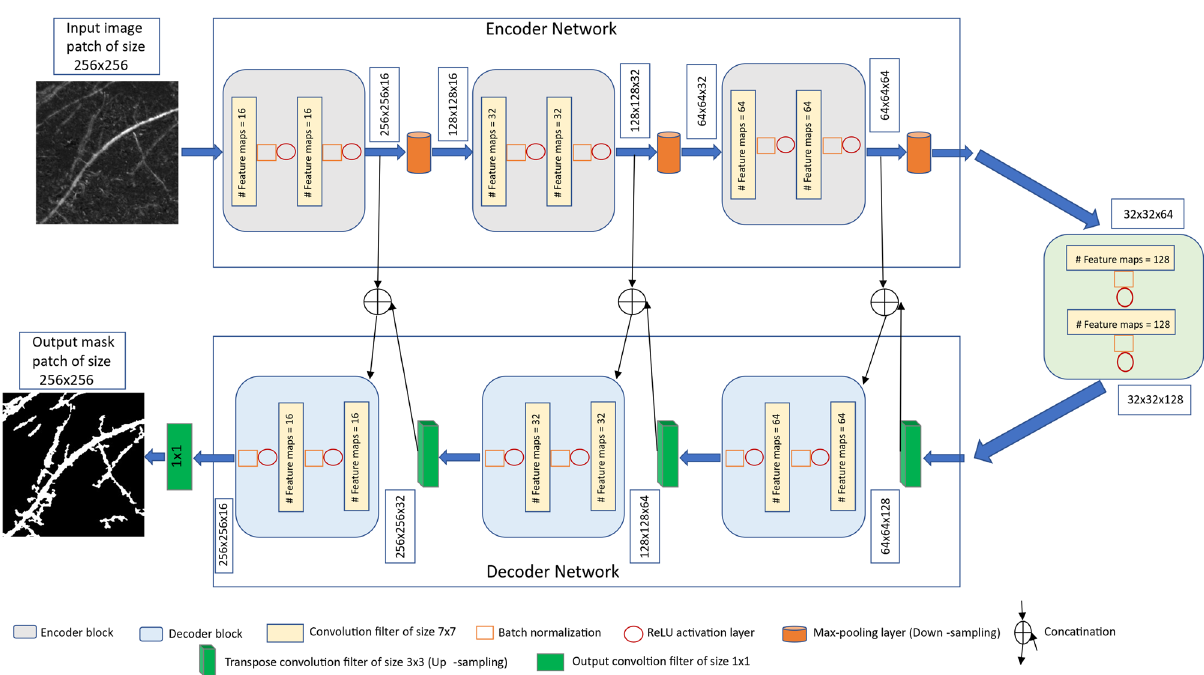
Figure 1. The proposed U-Net architecture for soil-root image